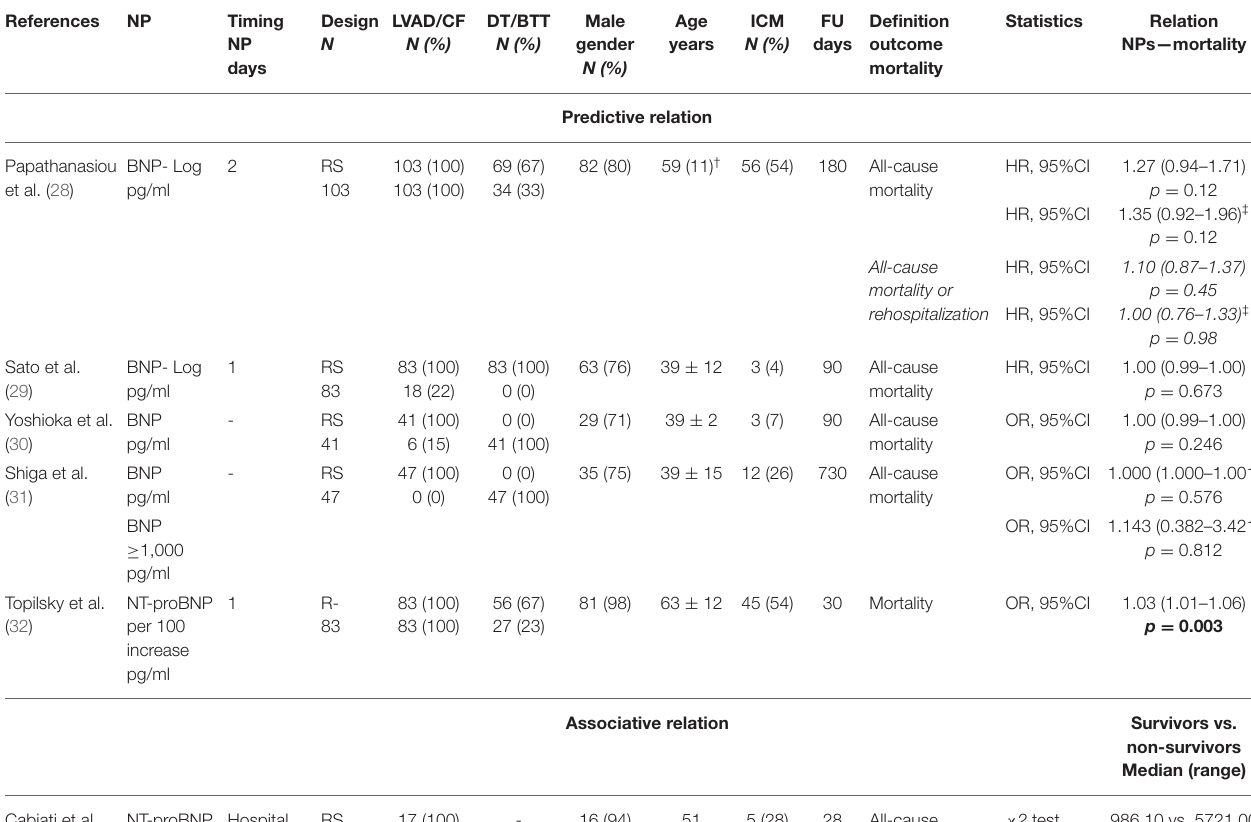
TABLE 2 | Baseline characteristics and outcomes of included studies for all-cause